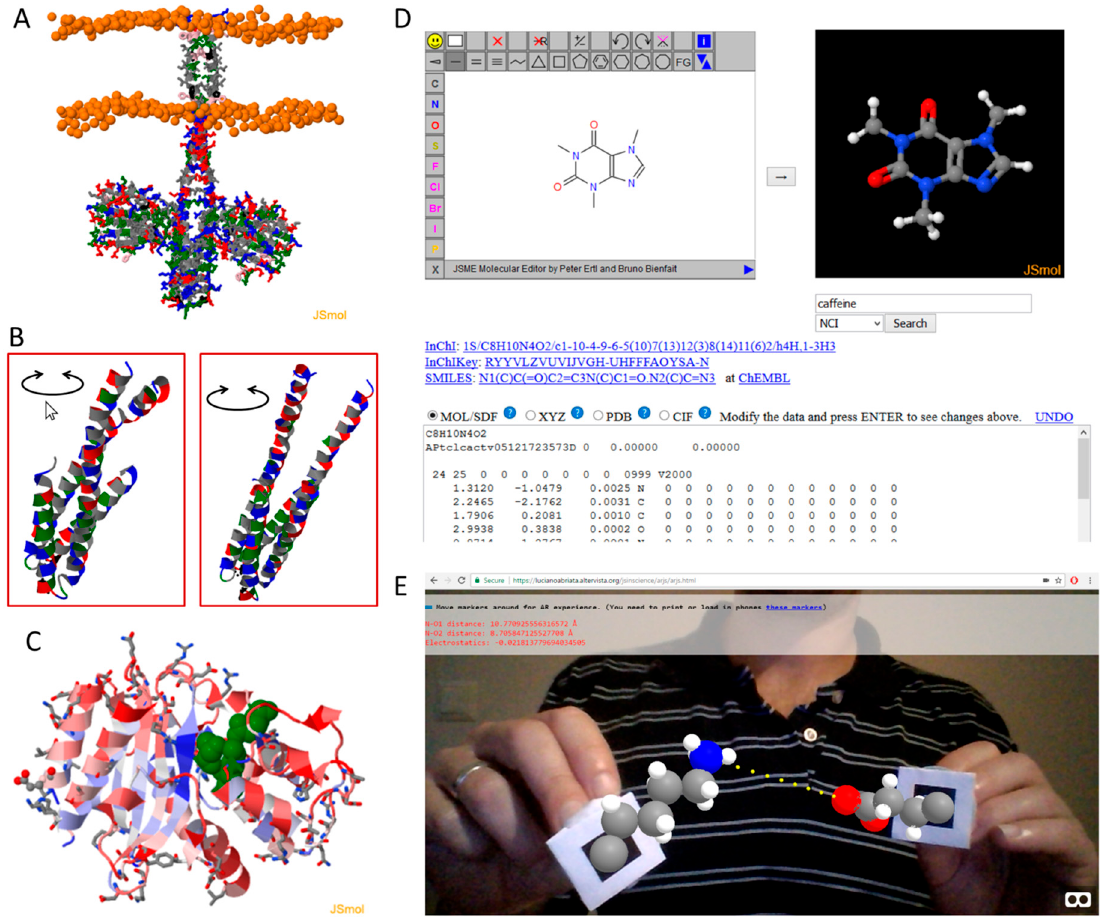
Figure 3. Molecular viewers and editors online. ( A ) JSmol displaying a 3D model of a histidine